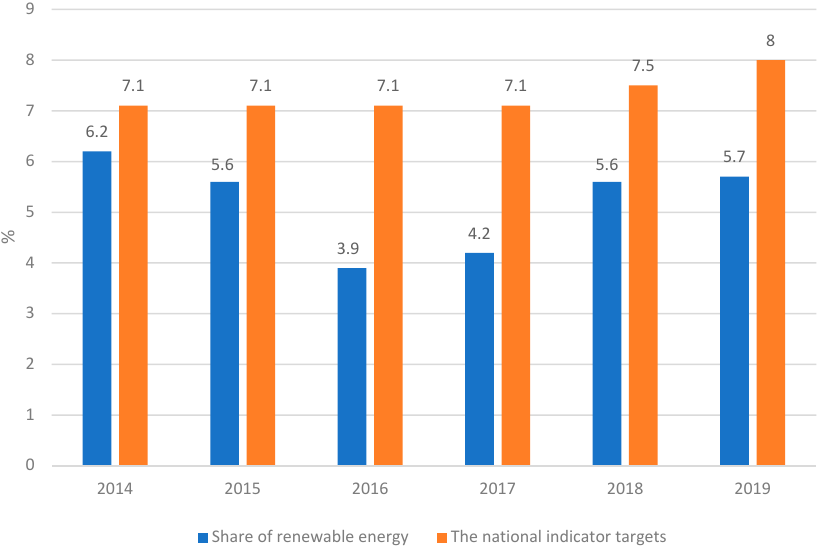
Figure 2. Share of renewable energy in final energy consumption in transport and the national indicator targets in 2014–2019 [56,57].